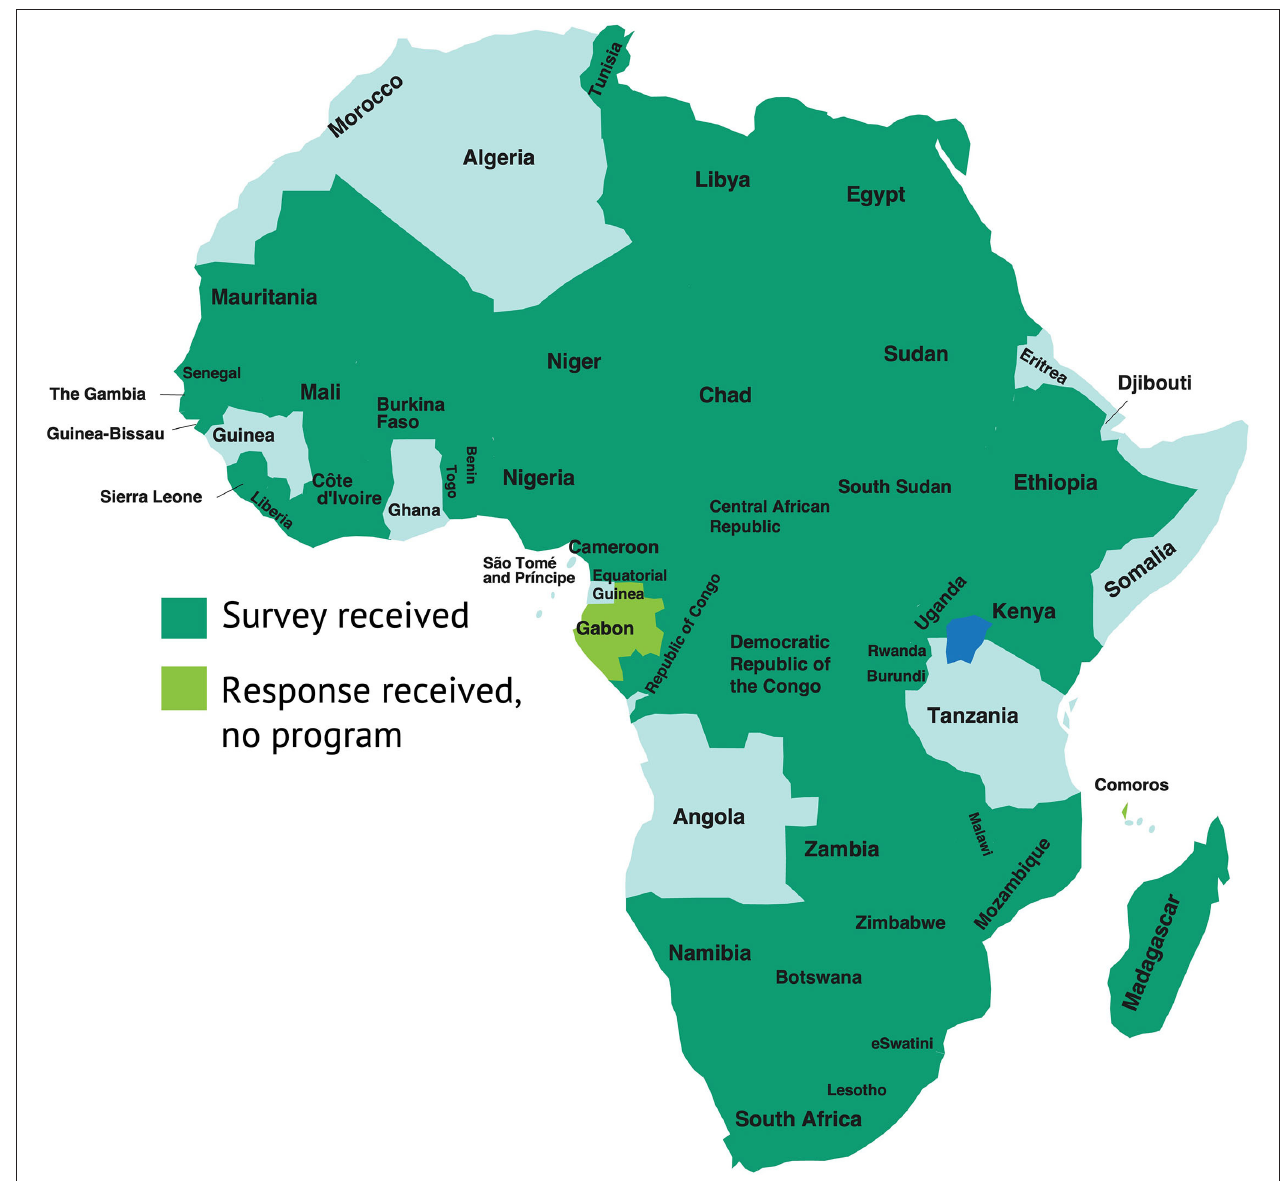
FIGURE 1 | Survey response status in